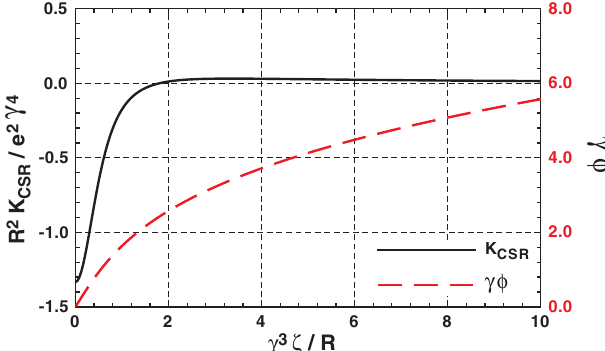
FIG. 2. (Color) K (cid:6) bend.